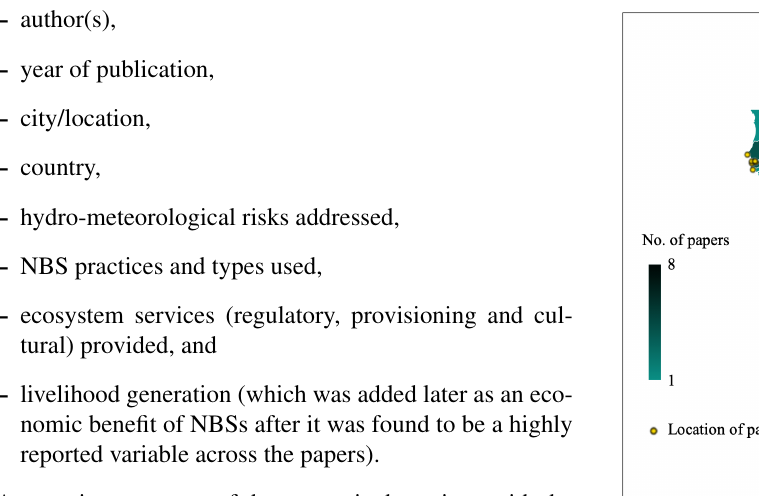
from western Africa, 20.5 % ( n = 18) from southern Africa, 34.1 % ( n = 30) from eastern Africa and 6.8 % ( n = 6) from central Africa. Four papers (4.5 %) covered all of